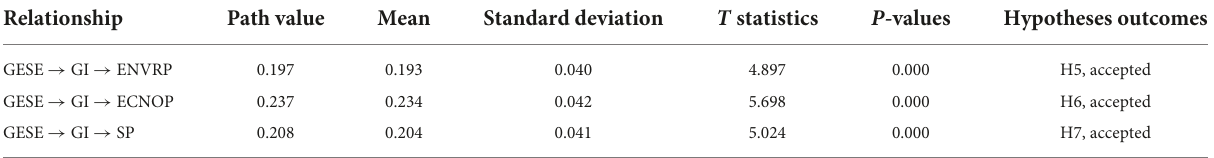
TABLE 6 Indirect relationship.